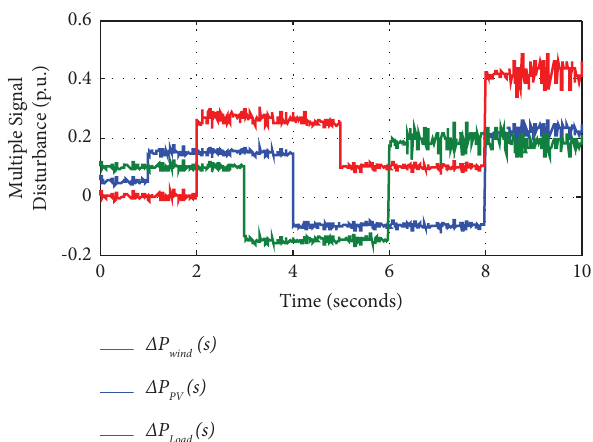
Figure 13: Power fuctuations in the wind, PV, and loads as main disturbances in scenario II.